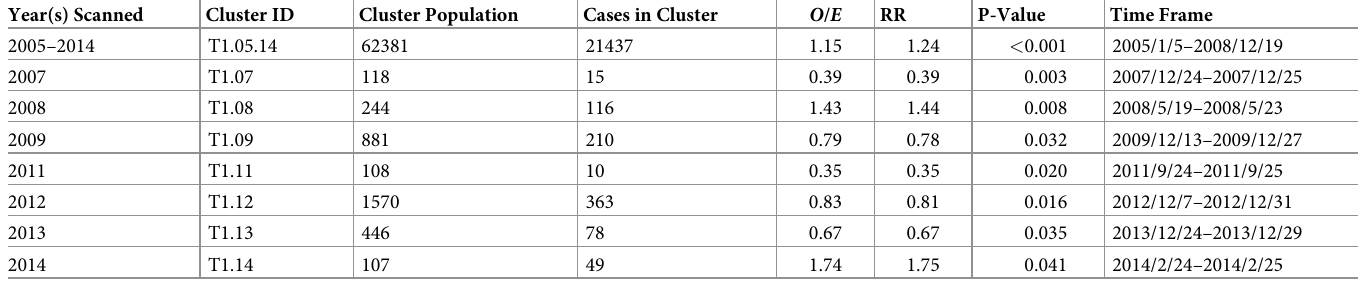
Table 3. Statistically significant clusters of high and low proportion of veterinary calls relative to public calls to the APCC from purely temporal scans of the entire study period (2005–2014) and each individual year.